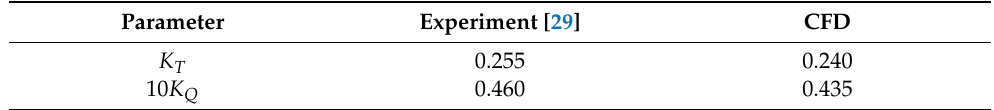
Table 3. The comparison of thrust and torque coefficients between the experiment and CFD at J = 0.71, σ = 1.763 in the smooth